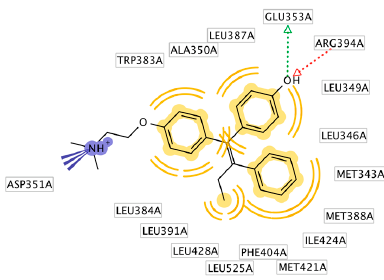
Figure 2. Best docked pose of 4-hydroxytamoxifen (4-OHT) with estrogen receptor-alpha (ER α ) using AutoDock 4.2.